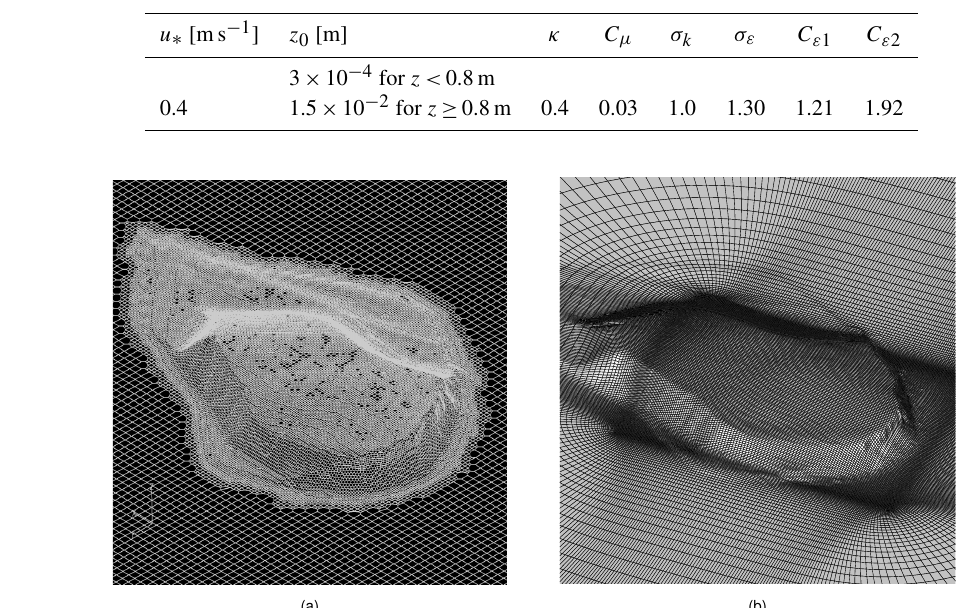
Table 4. Set of atmospheric parameters used for Bolund Hill test case.